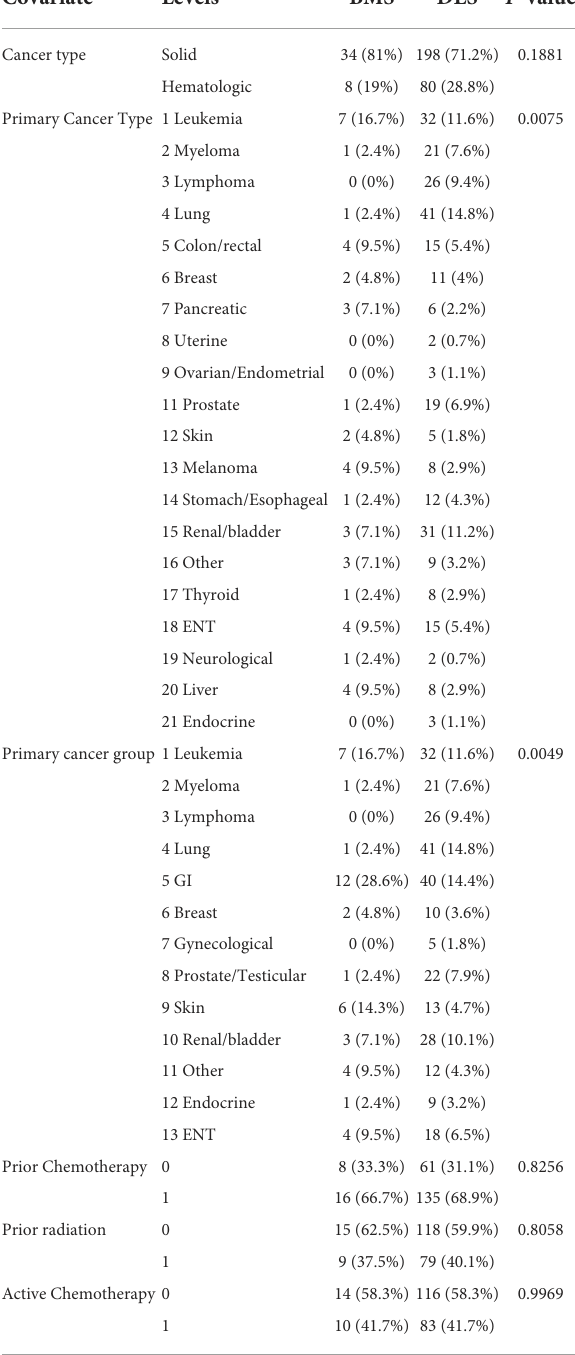
TABLE 8 Cancer characteristics by